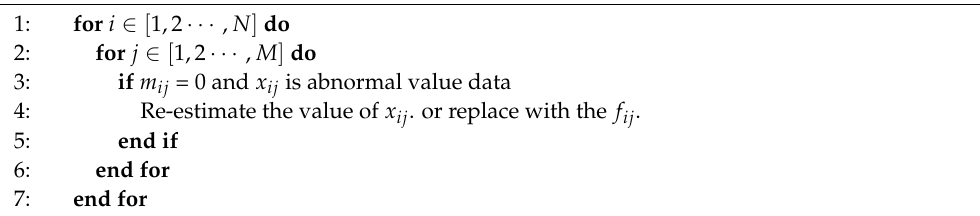
Algorithm 3 : Adjusting predicted values with ship domain